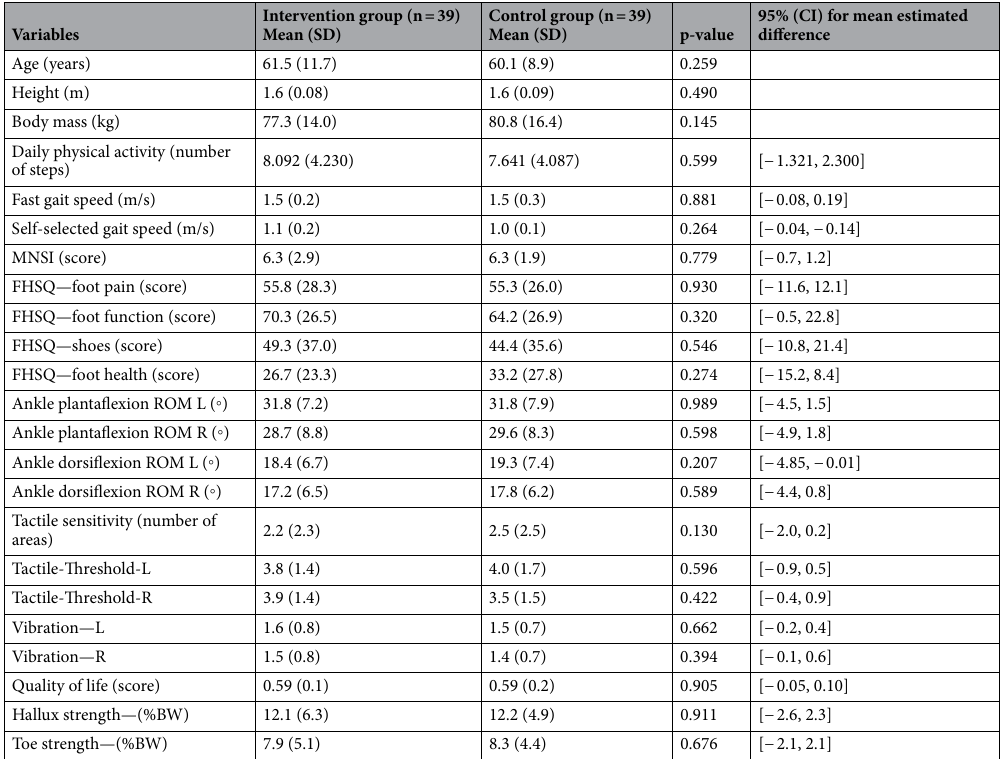
Table 1. Control and intervention group characteristics at baseline. MNSI Michigan Neuropathy Screening Instrument, FHSQ Foot Health Status Questionnaire, ROM range of motion, L left, R right, BW